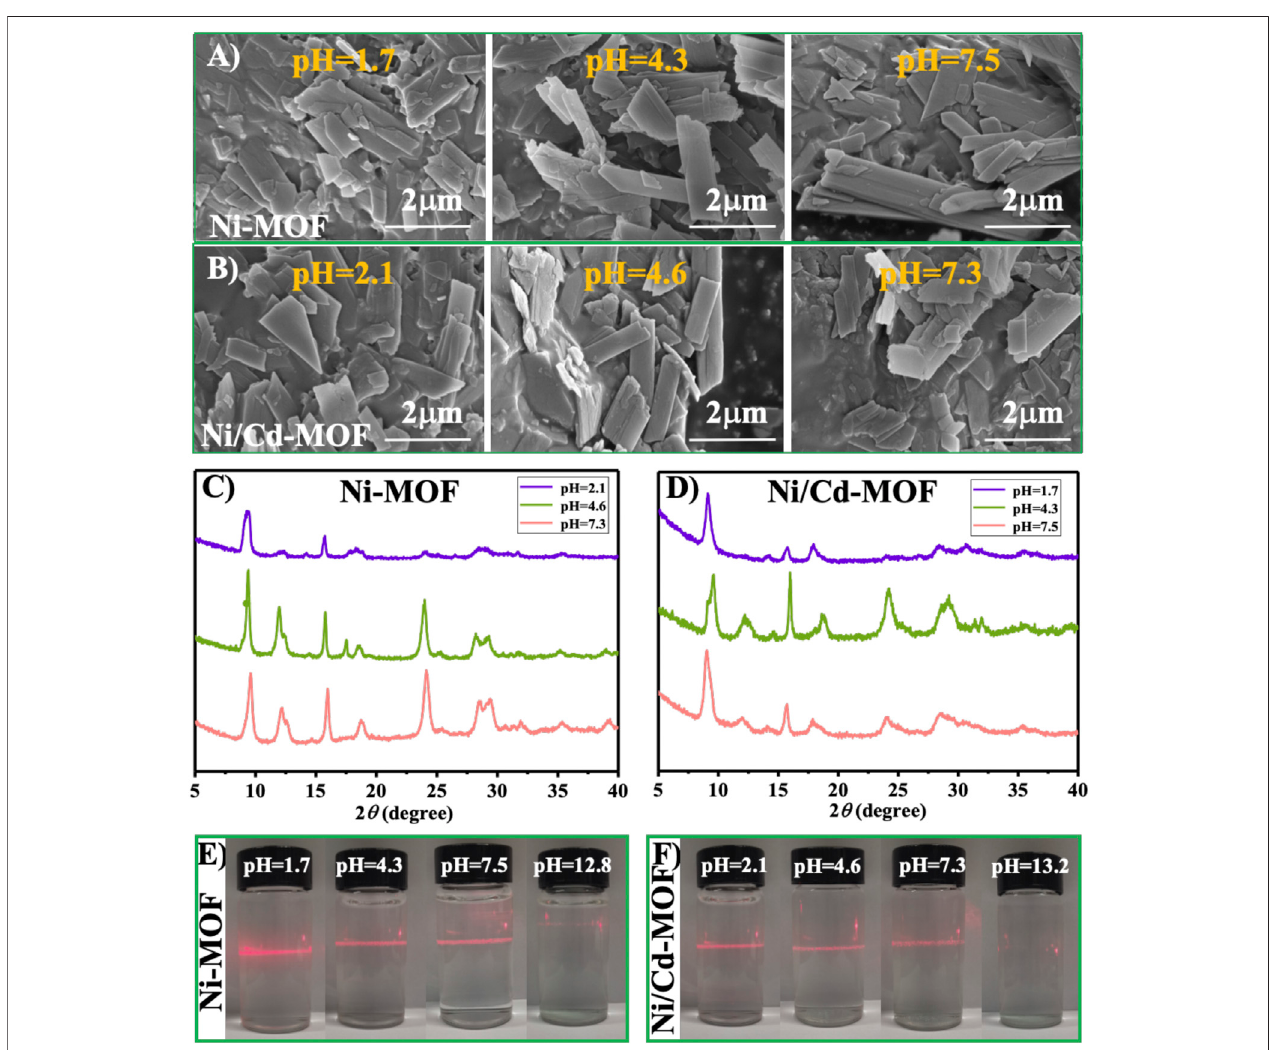
FIGURE 5 | SEM images of (A) Ni-MOF and (B) Ni/Cd-MOF at different pH; XRD patterns of (C) Ni-MOF and (D) Ni/Cd-MOF at different pH; Tyndall effect of (E) Ni-MOF and (F) Ni/Cd-MOF in aqueous solutions with different pH.